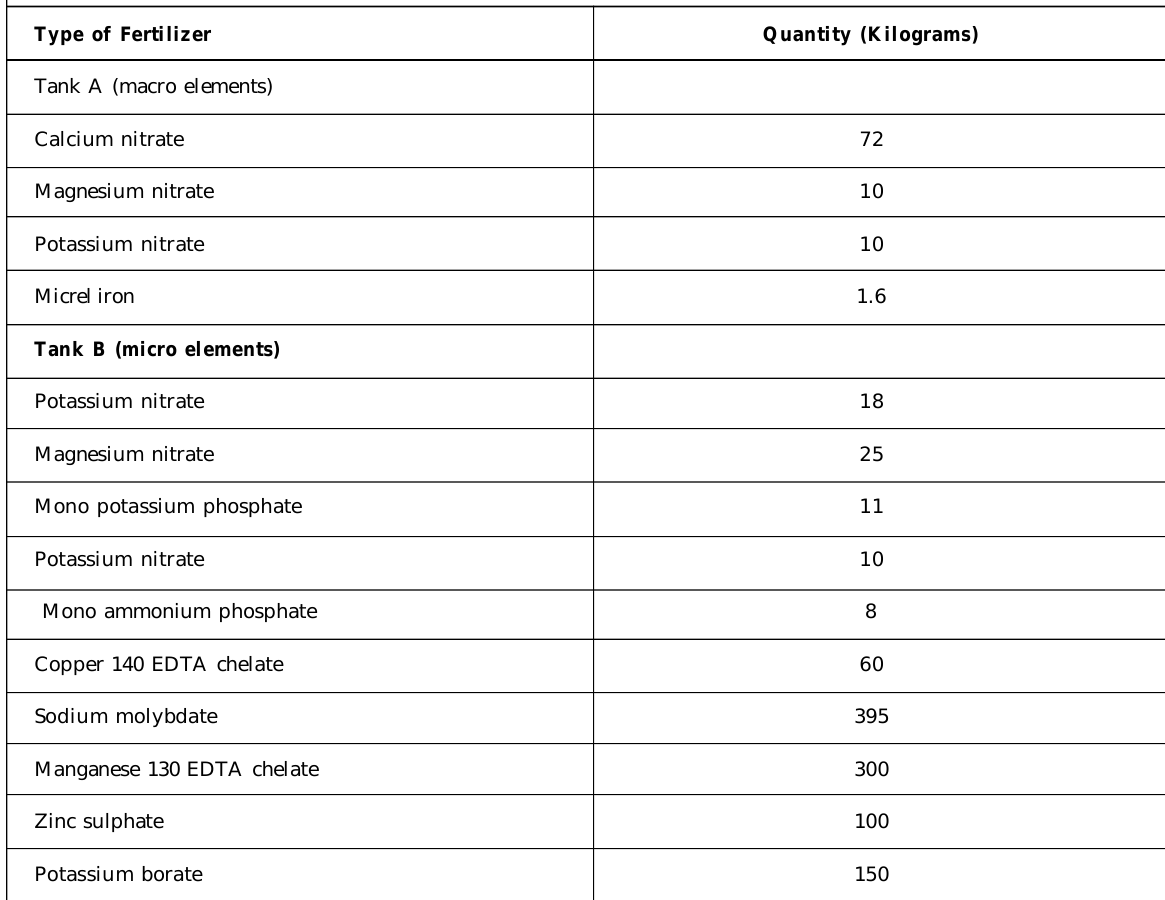
Table 1: Roses feeding program used at Finlay flowers Kericho Type of